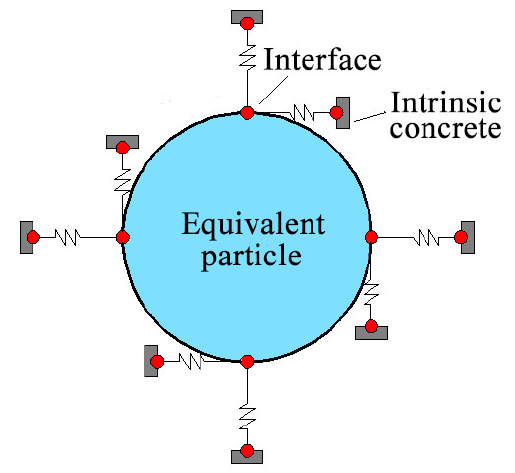
Figure 4. A schematic illustration of the interface model.